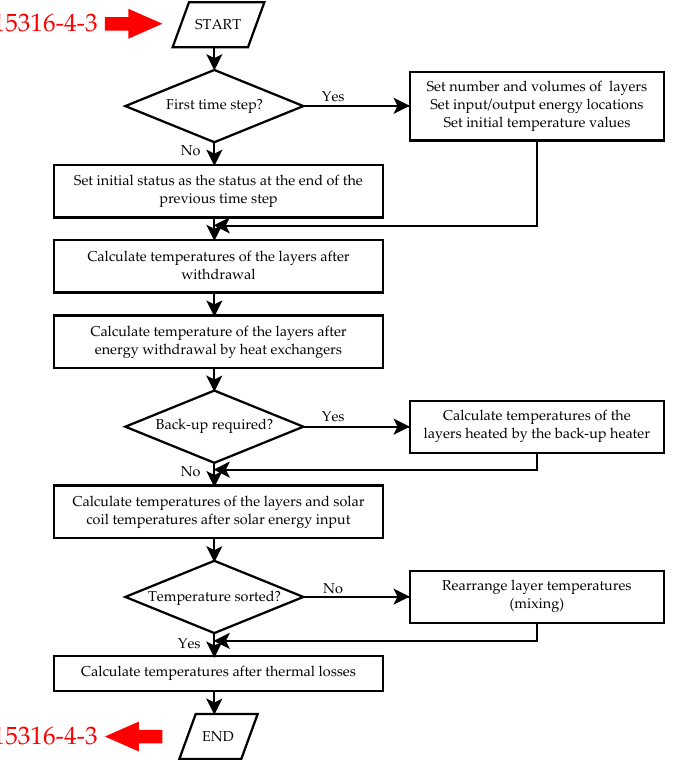
Figure 4. Diagram for hourly calculation of the stratified storage tank according to EN